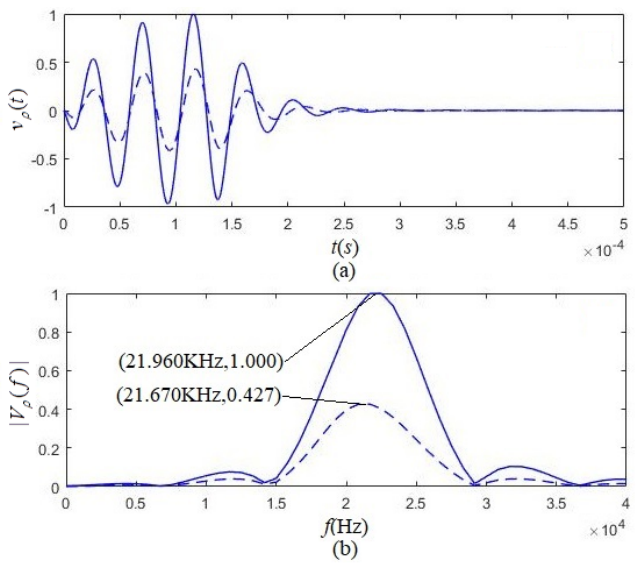
Figure 10. Acoustic signals radiated by tangentially polarized and radially polarized thin cylindrical transducers under the excitation of the same gated sinusoidal driving-voltage signal with the frequency of f s = 22.130 kHz, respectively. ( a ) Waveform; ( b ) Amplitude s